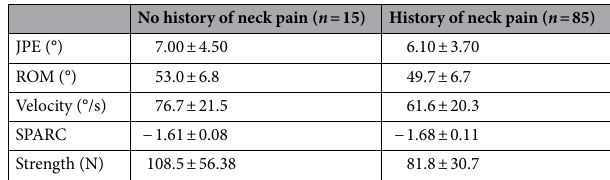
Table 3. Mean and SD of neuromuscular/kinematic features included in the NA. JPE Joint position error, ROM Range of motion, SPARC Spectral arc length.